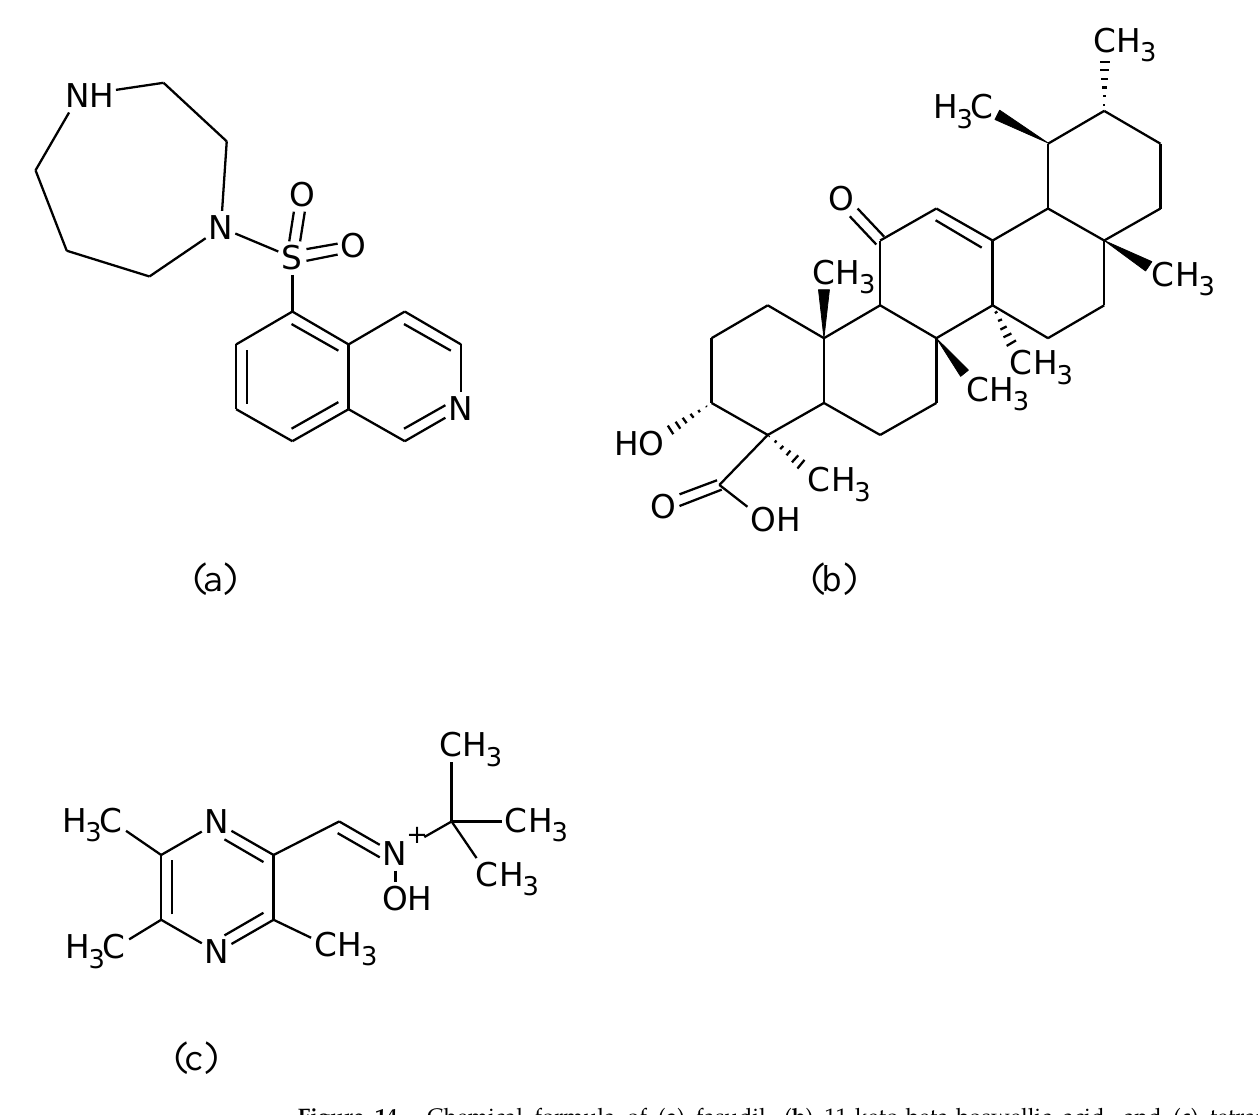
Figure 14. Chemical formula of ( a ) fasudil, ( b ) 11-keto-beta-boswellic acid, and ( c ) tetramethylpyrazine nitrone.